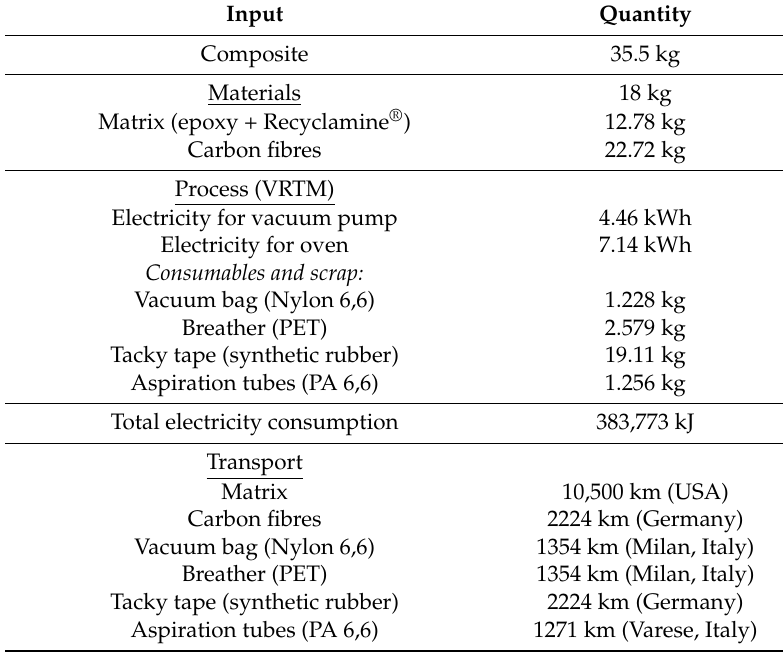
Table 5. Inventory analysis of the composite production using the VRTM